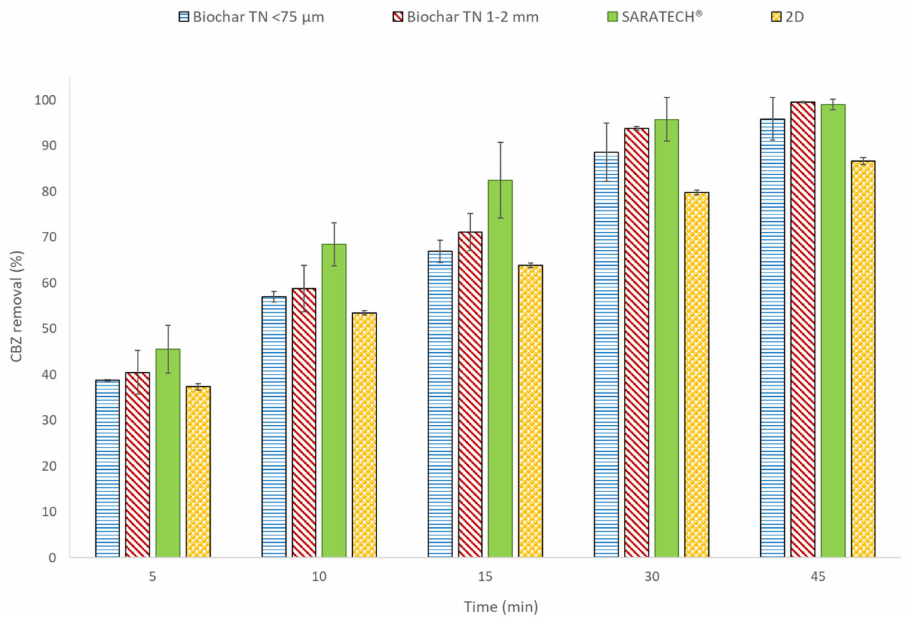
Figure 12. Effect of the particulate electrode on CBZ removal from aqueous solutions (operational conditions: j = 6.67 mA/cm2; NaCl = 0.1 M; CBZi = 10 mg/L; pH = 7; reaction time = 45 min; interelectrode distance = 7.5 cm; particulate electrode = 1 mg/mL solution; cathode = STS; anode =